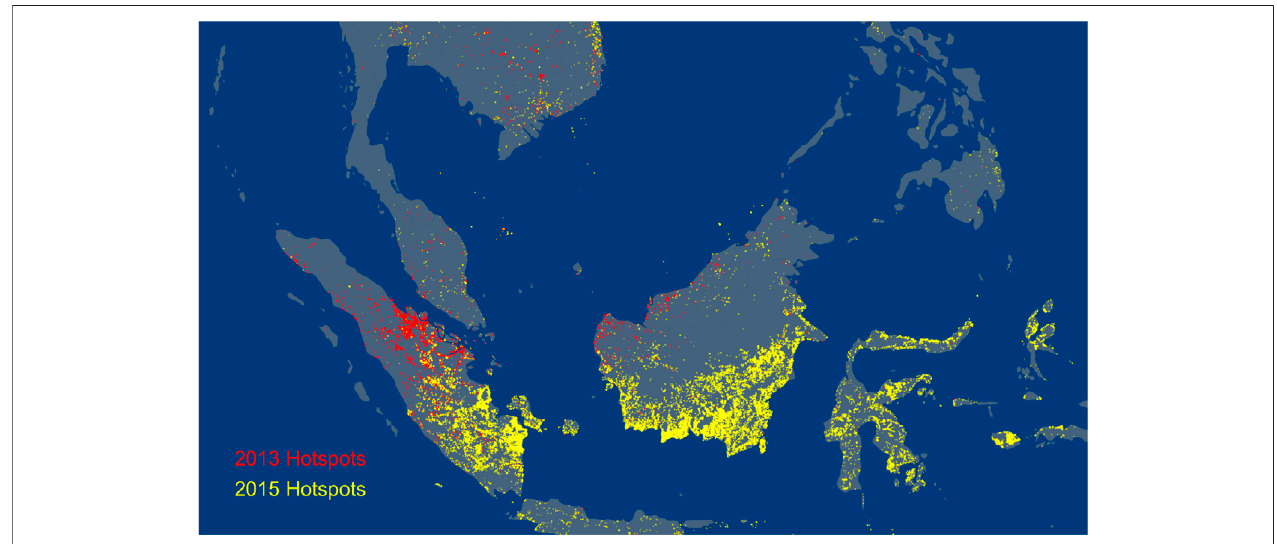
FIGURE 3 | Fire hotspots from NASA FIRMS MODIS Active Fire Detections satellite data for June 2013 (in red) and September-October 2015 in yellow) (NASA FIRMS, 2019).